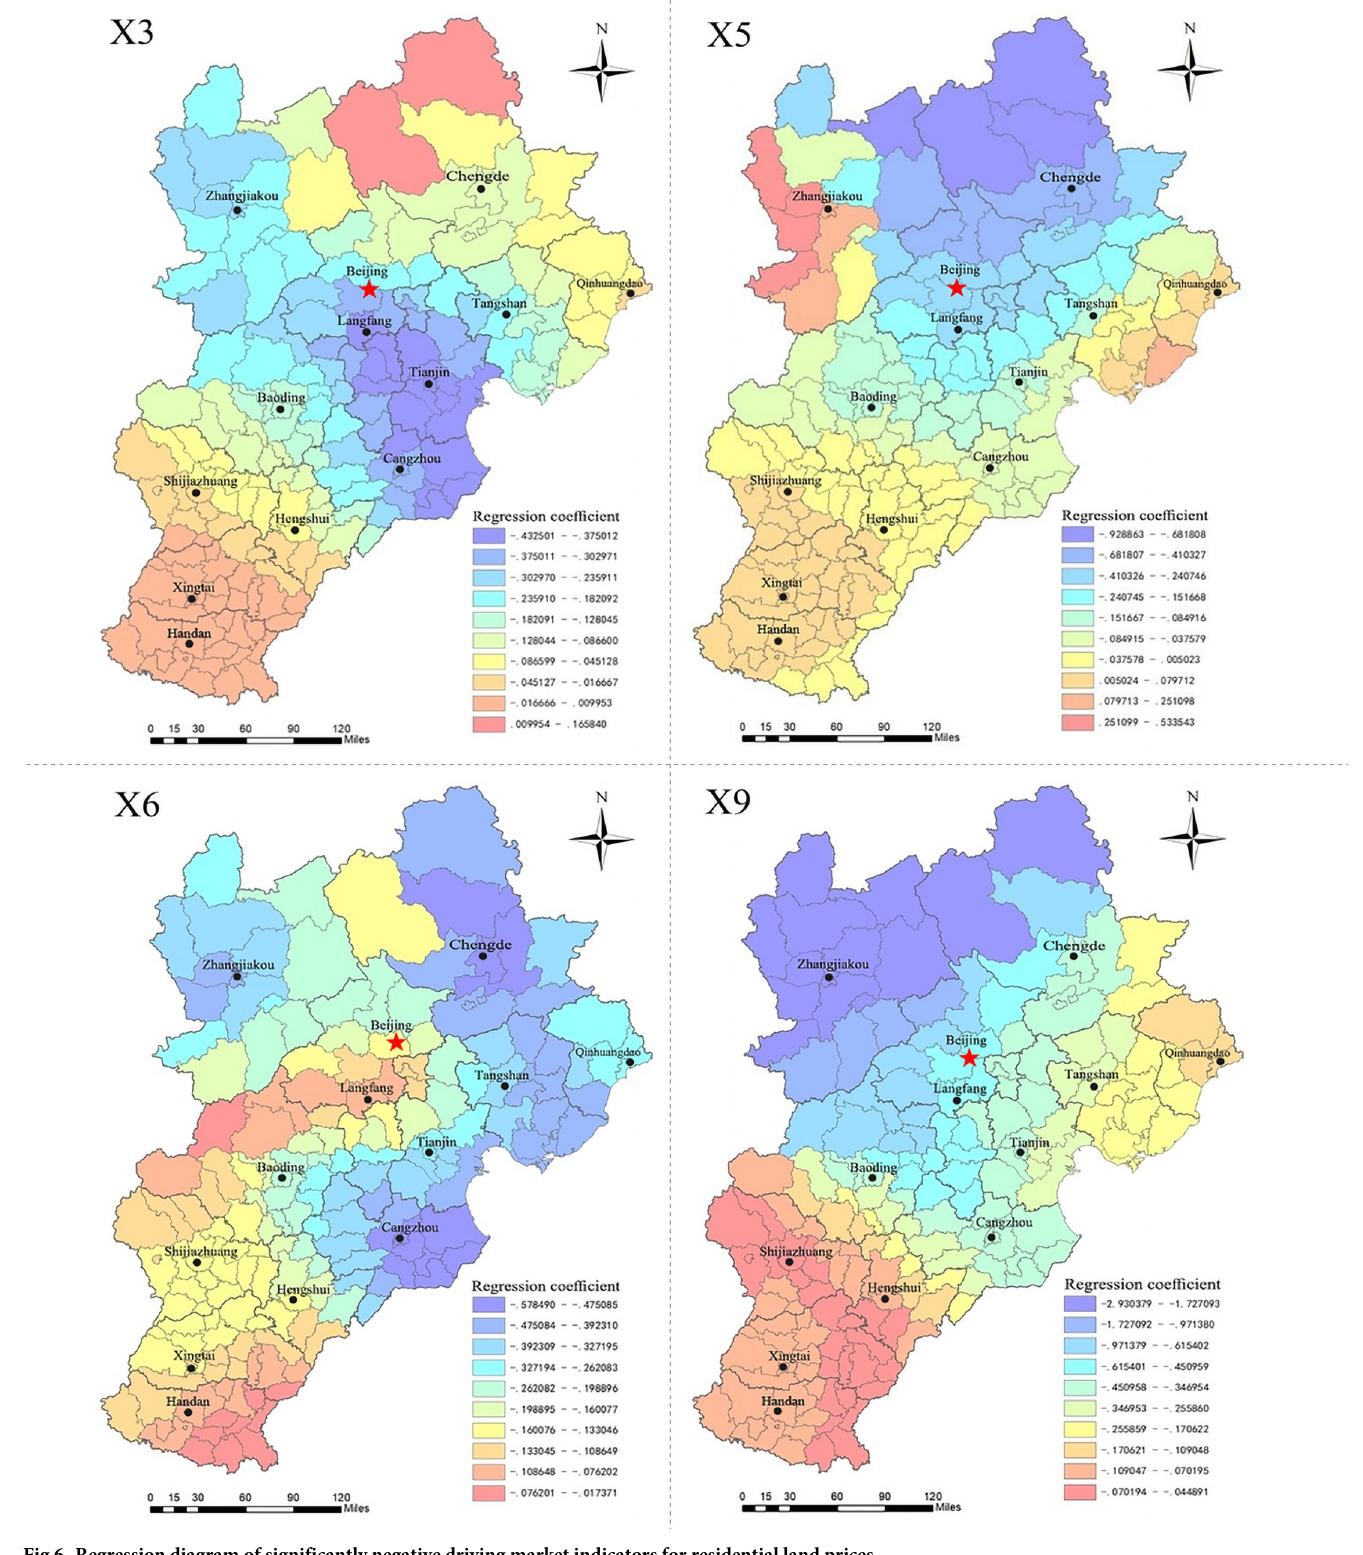
Fig 6. Regression diagram of significantly negative driving market indicators for residential land prices.